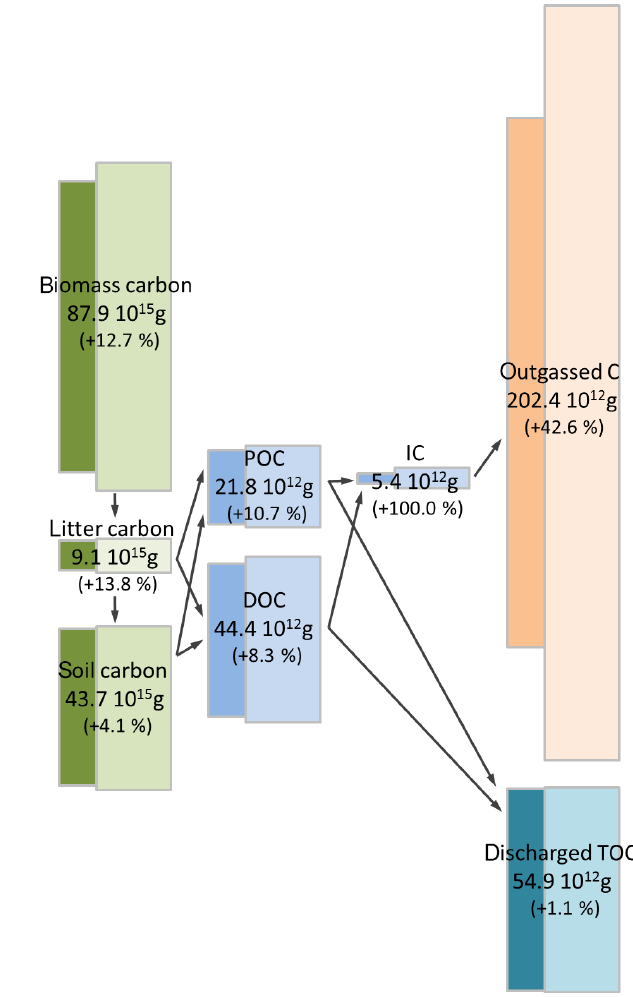
Figure 8. Averaged change in the basin carbon budget due to cli- mate change. Dark boxes indicate the amount of carbon during the reference period and light boxes during the future period (average over all SRES scenarios and GCMs). Amount is given for future period with relative change compared to reference. Arrows indicate the direction of carbon